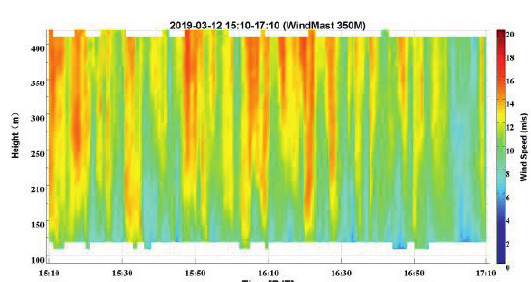
Figure 6. Wind THI diagram from 15:10 to 17:10BJT on 12 March 2019 observed by 350-M